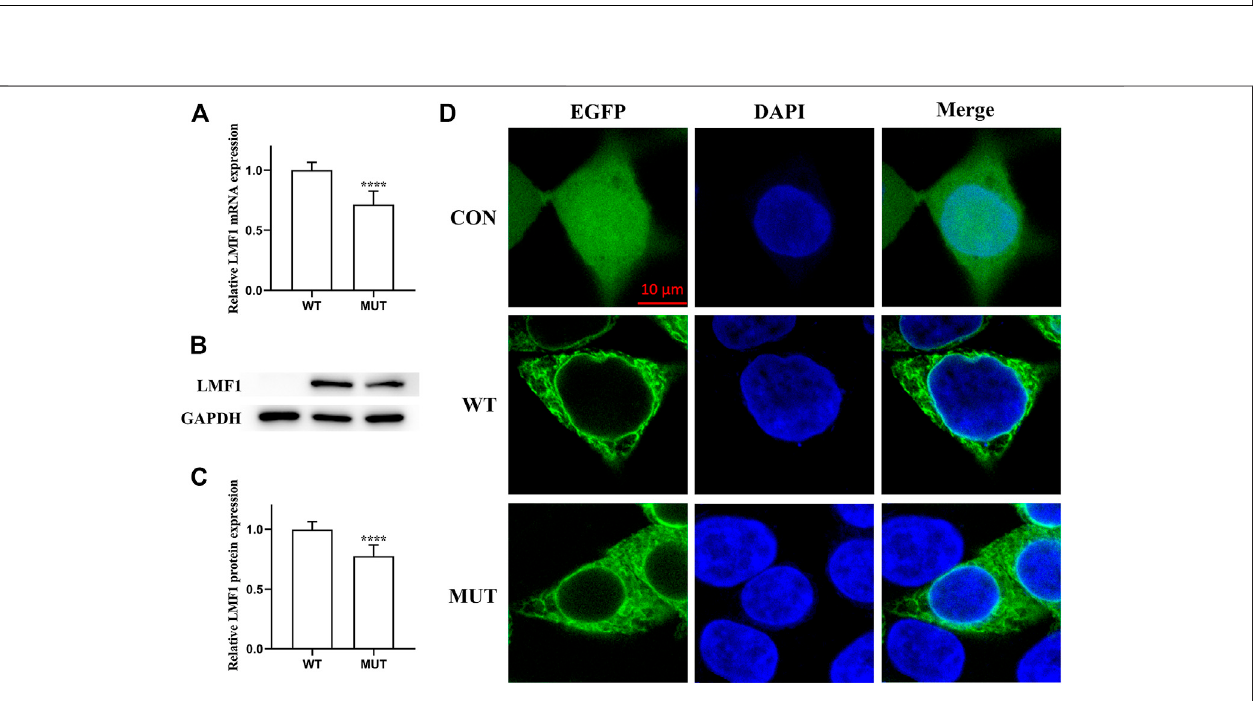
Figure 1B . The proband ( Ⅱ 4), his father ( Ⅰ 1), his brother ( Ⅱ 2), his son ( Ⅲ 4), and his daughter ( Ⅲ 3) carried the c.1523C > T missense mutation, while the proband ( Ⅱ 4) and his mother ( Ⅰ 2) carried the c.590G > A missense mutation ( Figures 1C,D ).